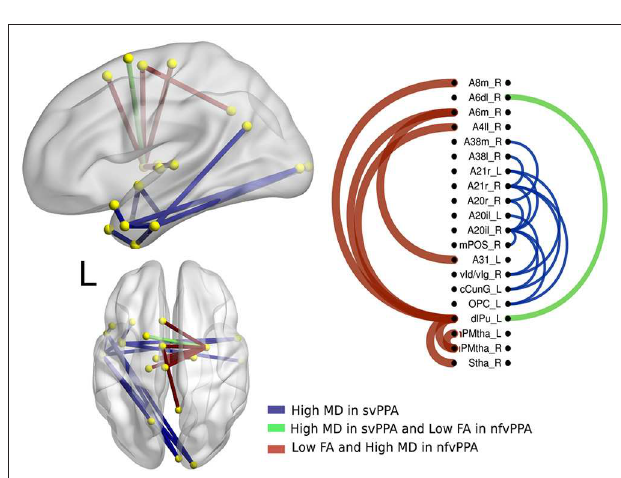
FIGURE 5 | Atrophic networks in PPA variants. The labels from Brainnetome represent the nodes and the edges show the changes in FA and MD, only the edges with changes are shown. The whole list of the nodes with the names is located in Supplementary Data . The left side of the figure shows alterations overlaid on a 3D template in the Montreal Neurological Institute’s standard space in neurological convention. The right side shows the same results displayed in 2D with the names of nodes in the Brainnetome Atlas and displayed at p < 0.05.